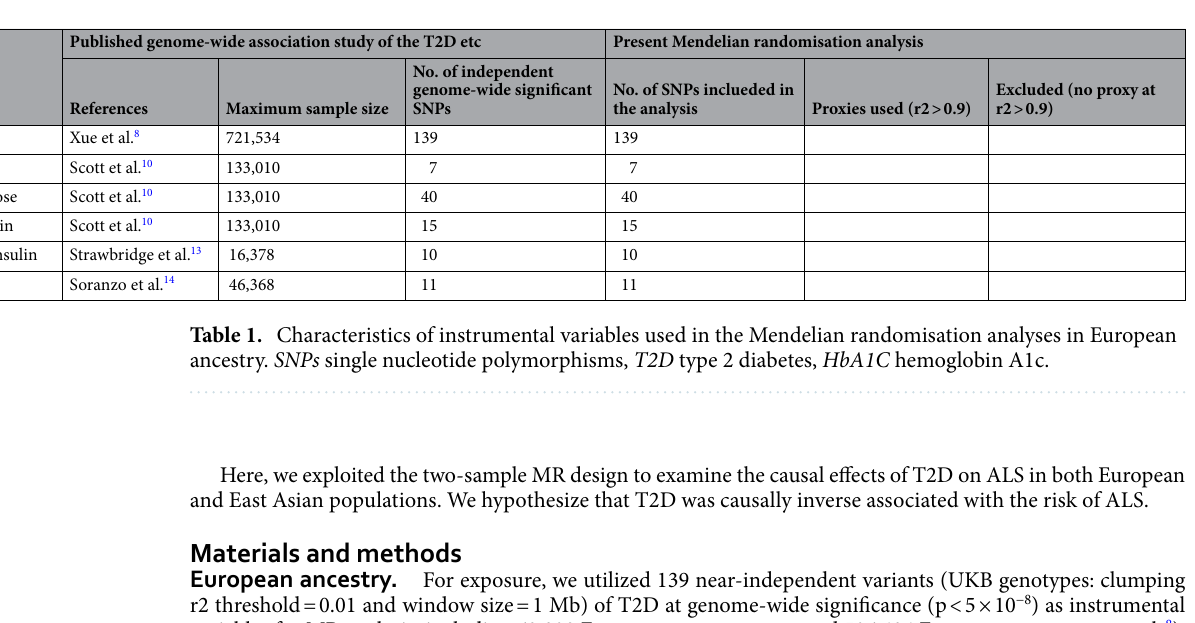
Figure 1. Subgroup meta-analysis of the effects on risk of ALS in patients with premorbid T2D between European populations and East Asian populations. ES effect size, CI confidence interval.